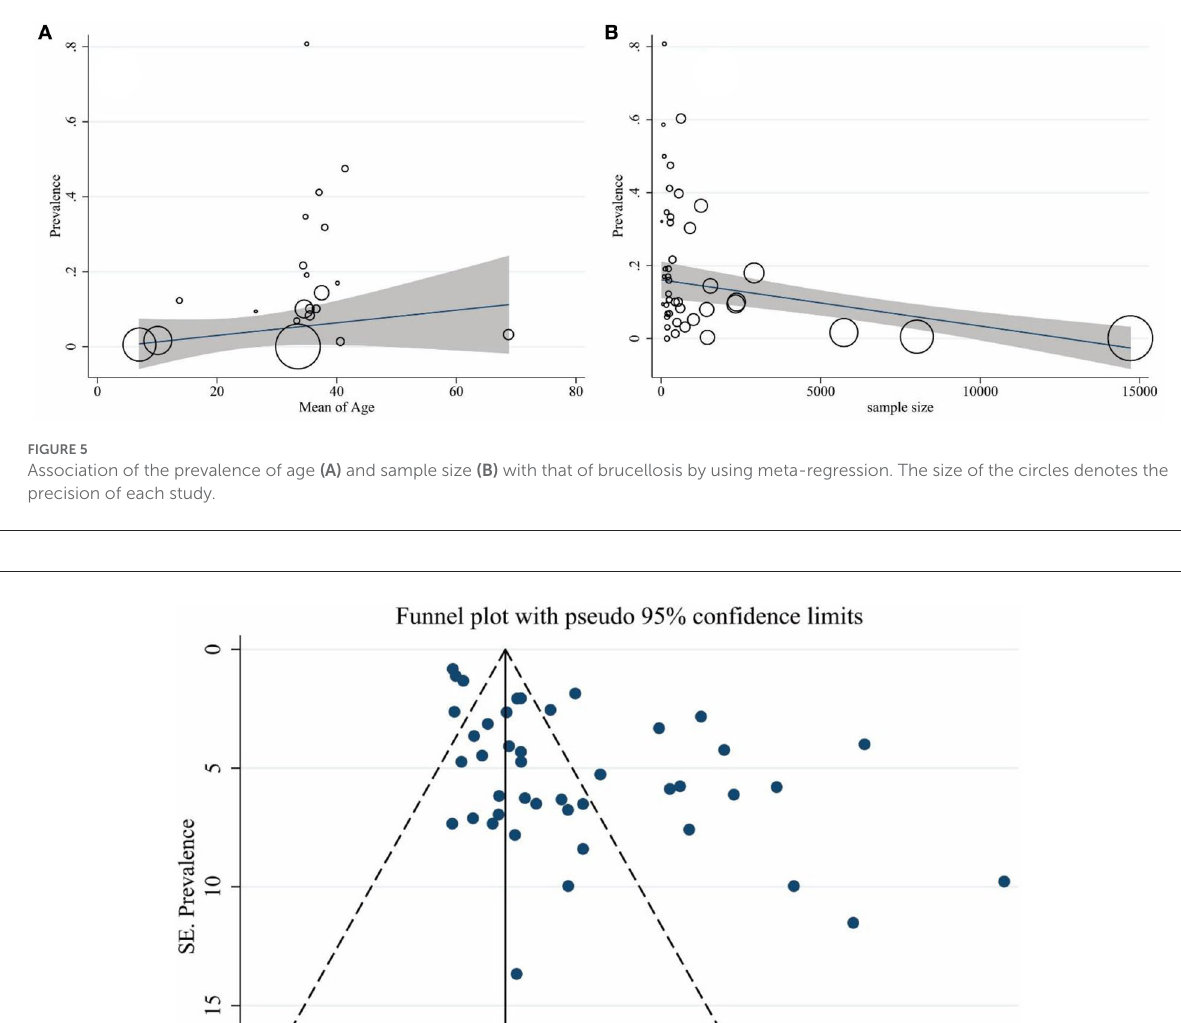
the evolution of the epidemiology of human brucellosis